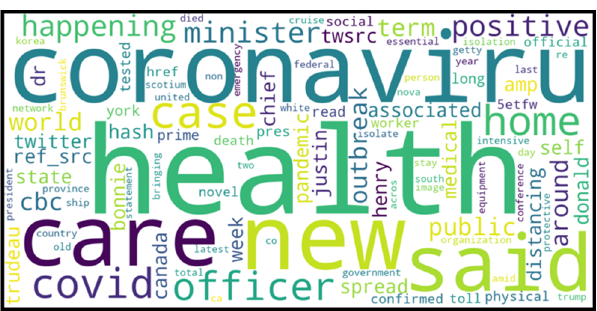
Figure 3. Shows a wordcloud representation of the top-100 features selected using TF-IDF. Upon constructing the network training model, it ended up with 471 nodes only.